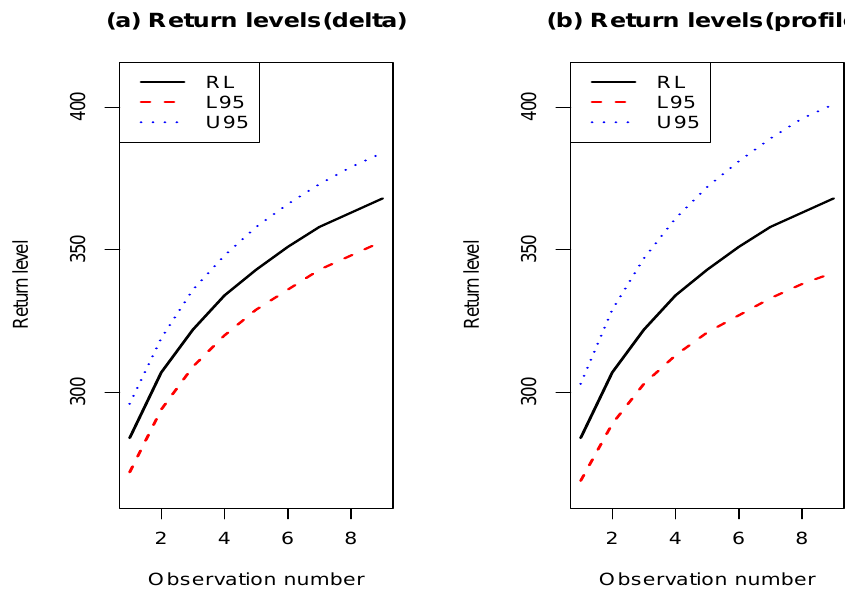
Figure 10. Return level plots for the model GEVD r = 8